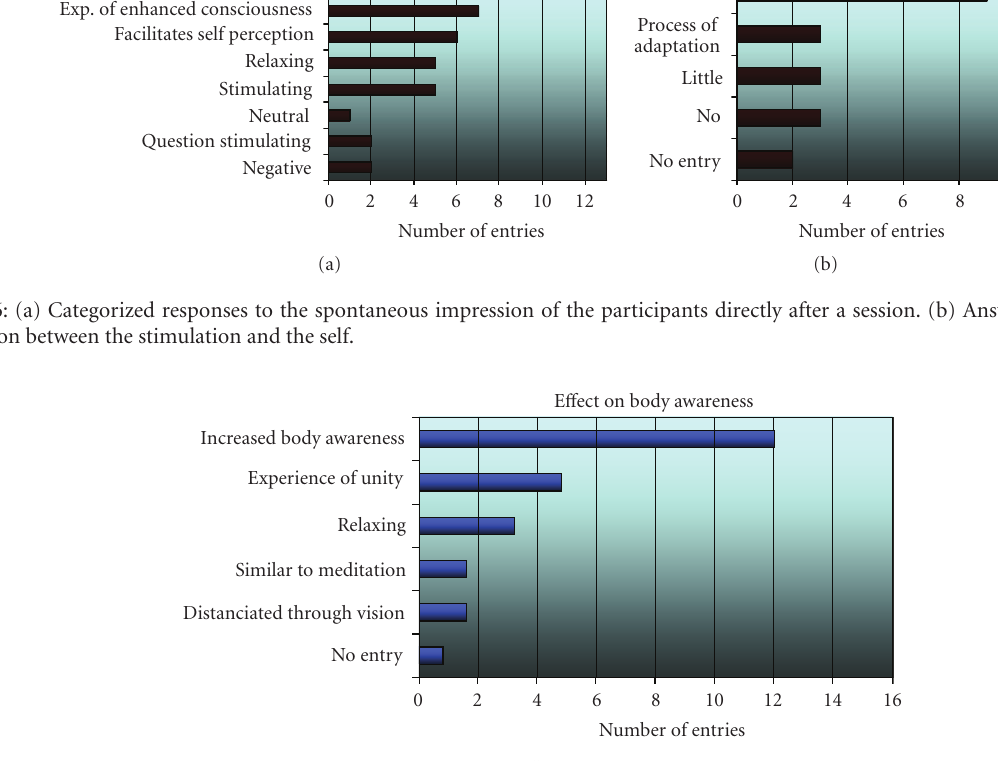
Figure 7: Answer categories of the question “What was the e ff ect on your body